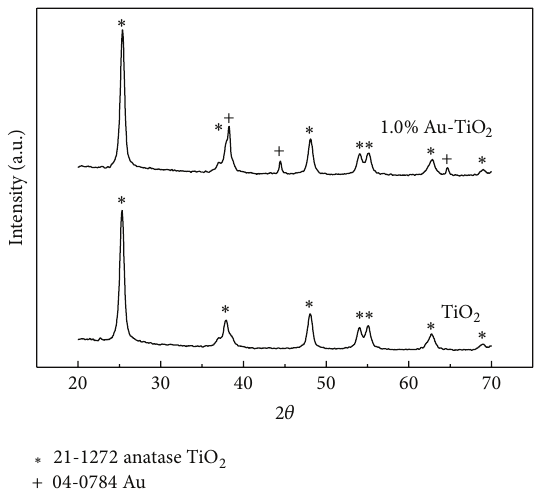
Figure 3: XRD patterns of the TiO 2 and 1.0mol% Au-loaded TiO 2